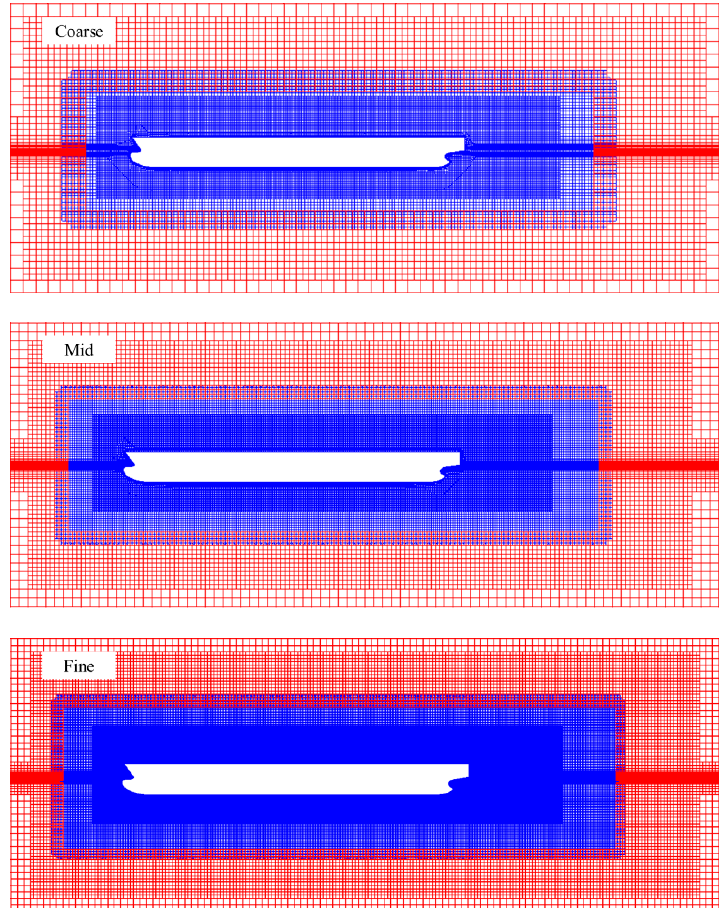
Figure 4. Grids distributions with different mesh resolutions (top: coarse; middle: mid; bottom: fine).